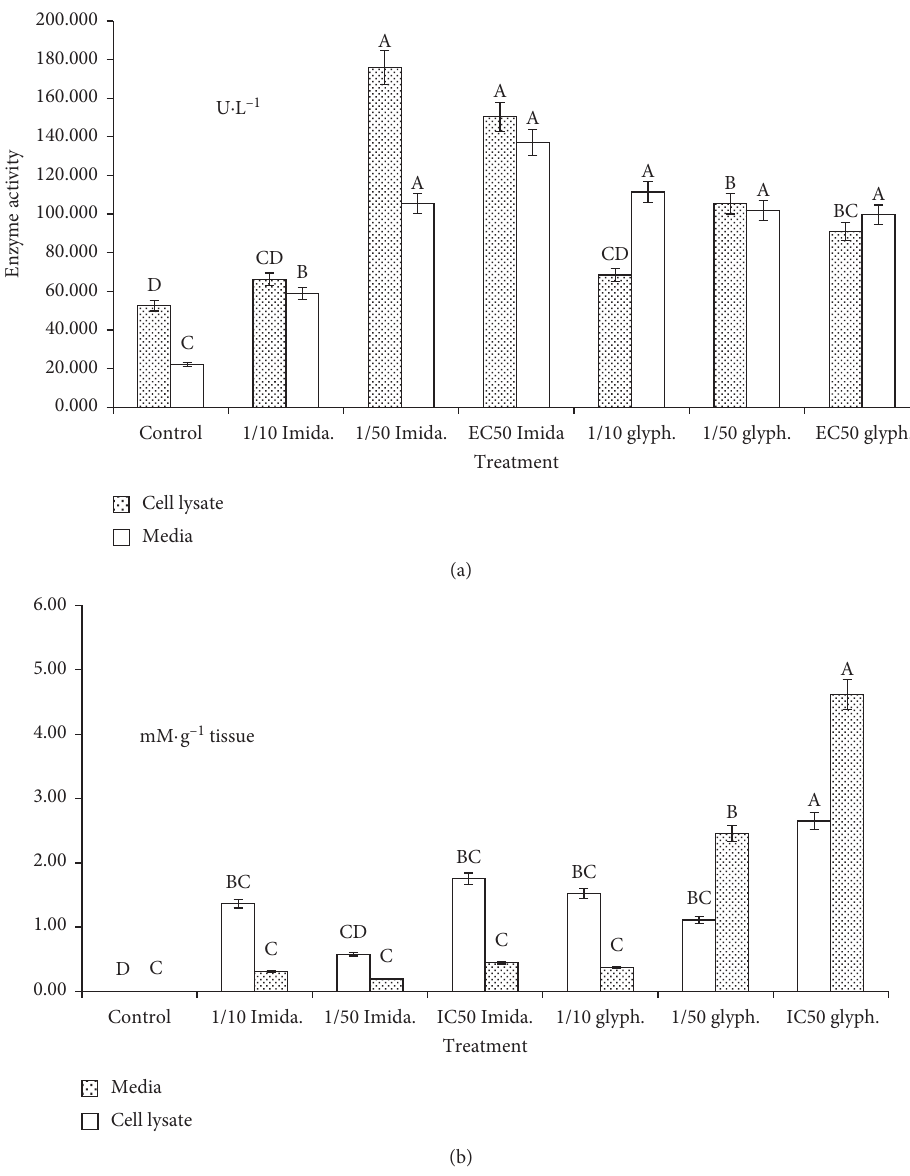
Figure 3: (a) Lactate dehydrogenase (LDH) activity (U L − 1 ) and (b) malondialdehyde (MDA) level (mM g − 1 tissue) in WPM-Y.1 cells exposed to different concentrations (mM) of imidacloprid and glyphosate. Each value indicates the mean of 3 replicates ±